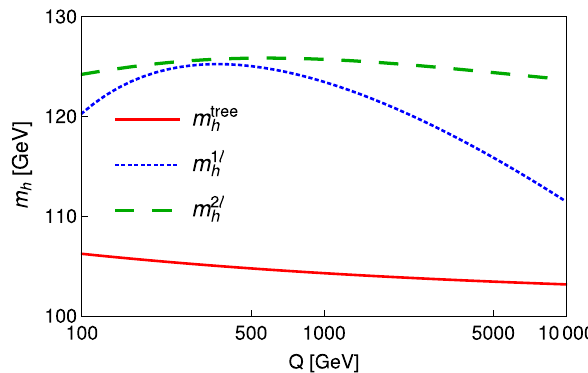
Fig. 5 Lightest Higgs mass m 2 as a function of the renormalisation h scale Q , considering only the running of SM parameters. Red curve: tree level; blue dot-dashed curve: one-loop order; green dashed curve: two-loop